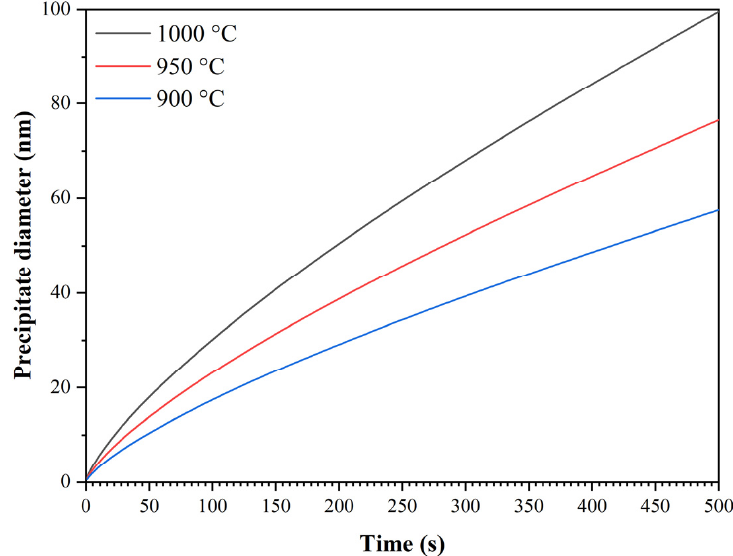
Figure 26. Dependence of precipitate size on the time and temperature of precipitation calculated